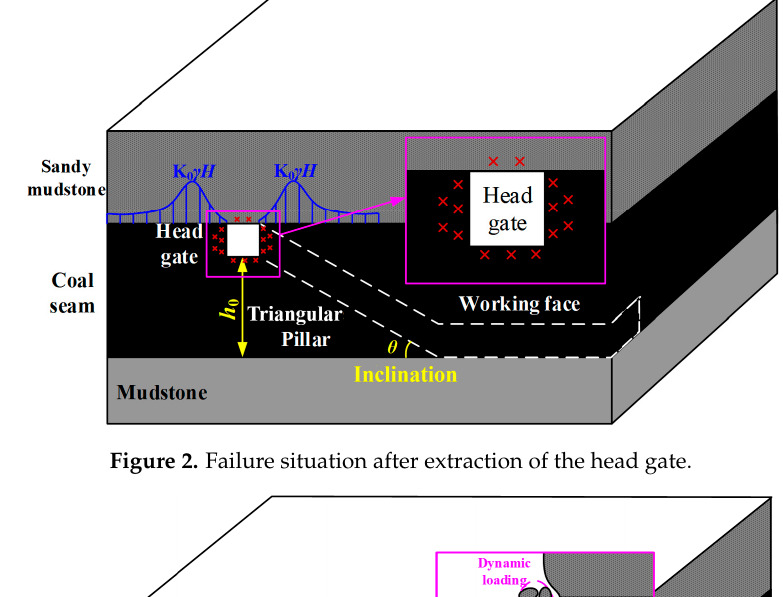
Figure 2. Failure situation after extraction of the head gate.